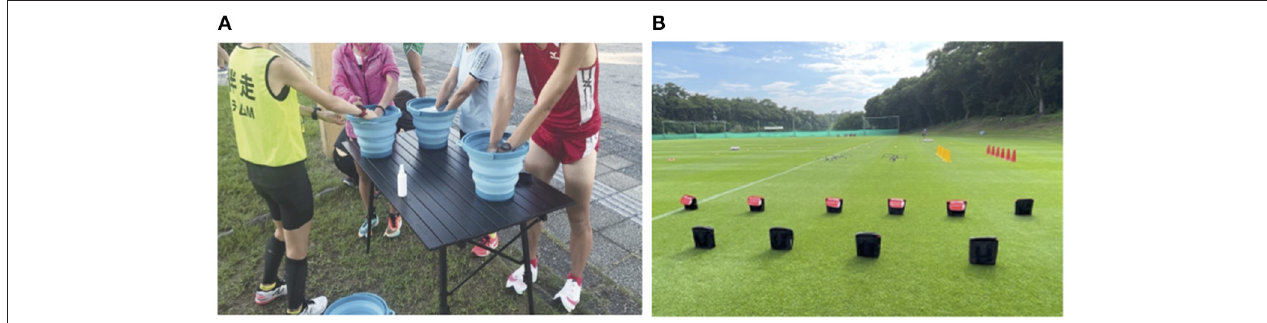
FIGURE 3 | Heat and infectious disease countermeasure support for each athlete. (A) Forearm cooling during precooling (Takahashi et al., 2021). (B) Hydration measures using individual bottles.